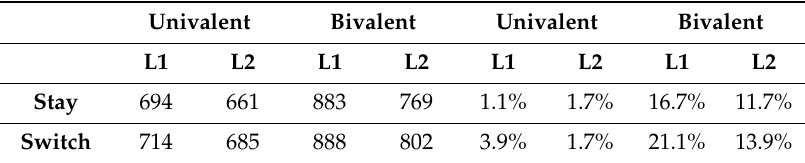
Table 2. Mean reaction times ( left ) and error rates ( right ) in each condition in Experiment 1: